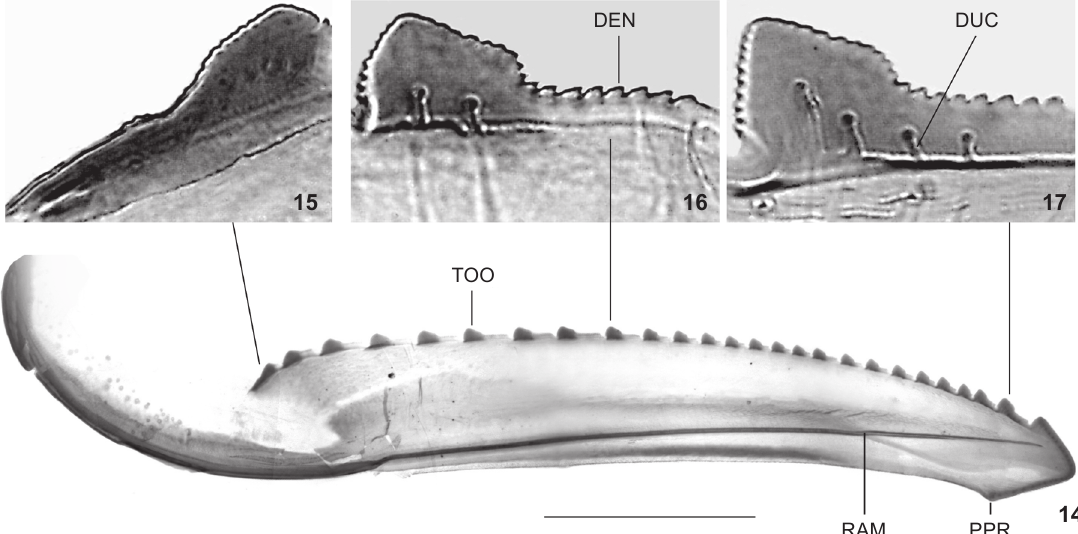
Figures 14-17. Scoposcartula talitae , second ovipositor valvula: (14) general lateral view; (15) first tooth; (16) tooth on median portion; (17) last tooth. (DEN) Denticle, (DUC) duct, (PPR) preapical prominence, (RAM) ramus, (TOO) tooth. Scale bar: 14 = 0.5